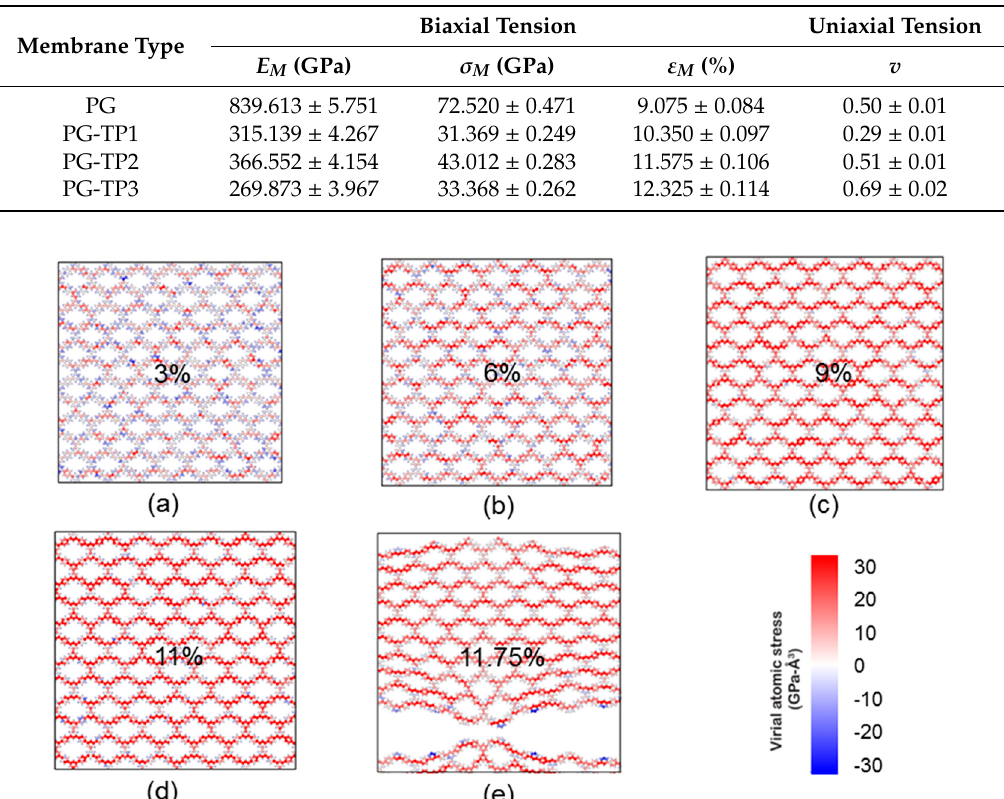
Figure 4. Stress distribution in PG-TP2 sheet with increasing biaxial stress. The stress at each atom is represented by its color with red regions corresponding to the areas of highest stress (see the color bar). The strain in the figure is ( a ) 3%, ( b ) 6%, ( c ) 9%, ( d ) 11%, and ( e ) 11.75%.